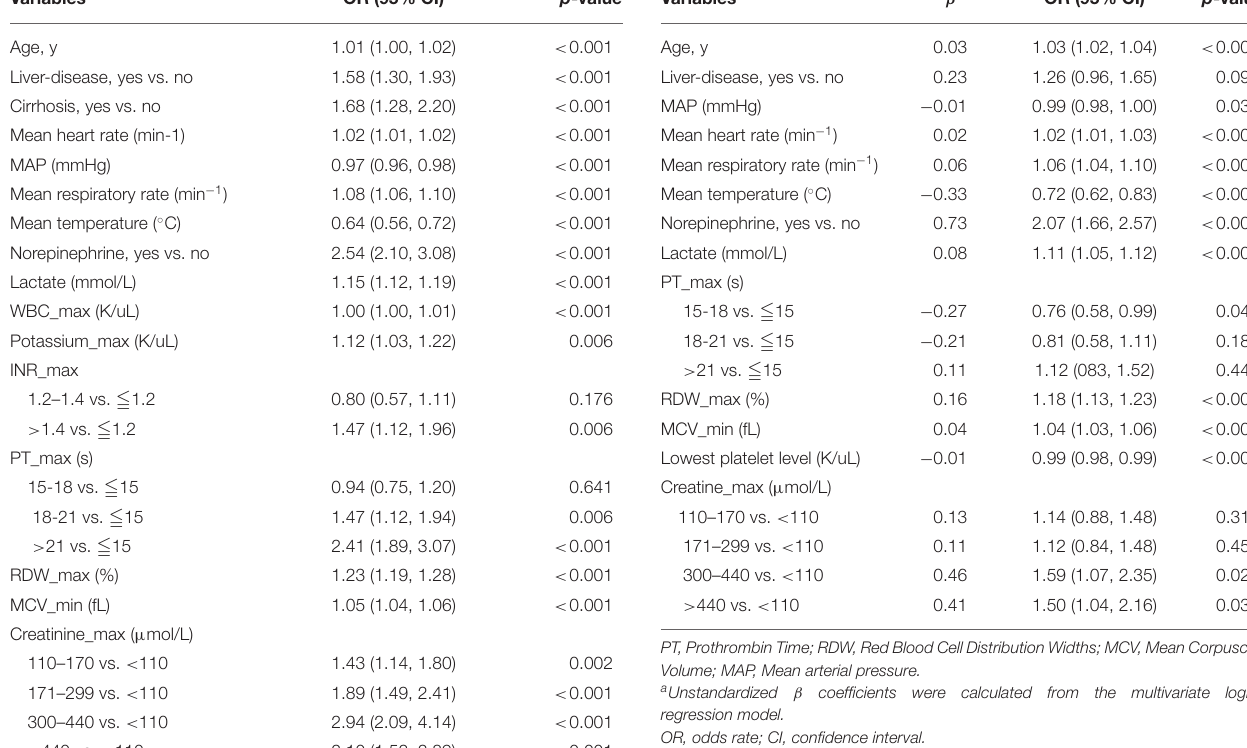
TABLE 2 | Factors independently associated with 28-day mortality of patients with SIC by univariate logistic regression analysis in training cohort. Variables OR (95% CI) p -value